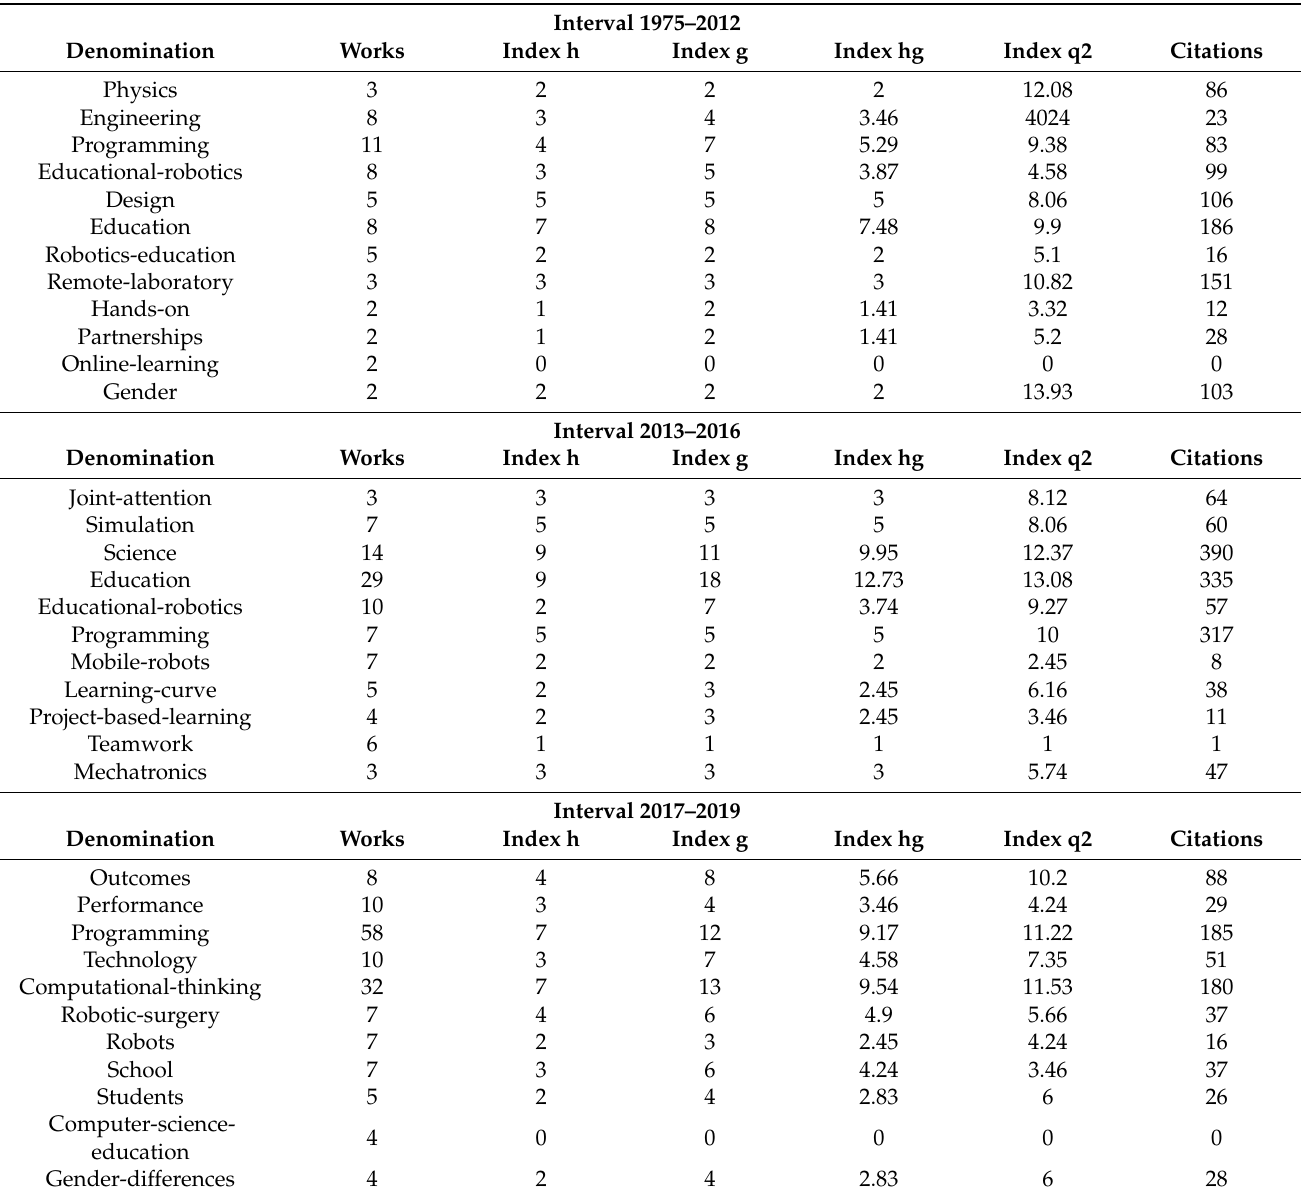
Table 10. Thematic performance in robotics in education